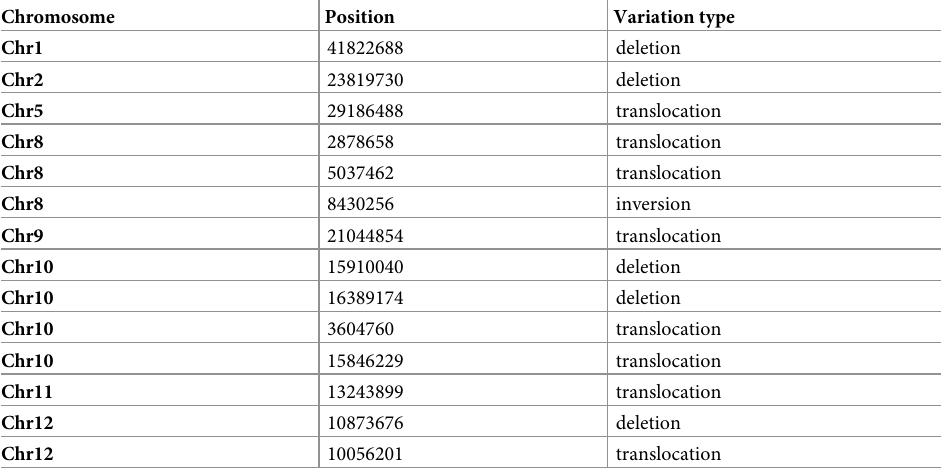
premature stop codon. Consequently, the mutant line flowered 35 days earlier than Gimbozou under natural LD light conditions, similarly to G123 . When comparing the expression patterns of the main flowering regulatory genes in X61 and G123 under the LD conditions, as expected Hd3a displayed higher levels in both mutant lines compared to their corresponding wild types. The RFT1 levels were higher in Gleva than in G123 , probably due to their differences in vegeta- tive cycle duration. Despite there being some connections between the two flowering regula- tory pathways, Hd3a expression is regulated by Hd1 and Ehd1 , while RFT1 expression is regulated by Ehd1 [32]. In regions located at northern latitudes with a temperate climate, varie- ties can often be found with non-functional Hd1 alleles. As Hd1 is an inhibitor of flowering under LD conditions, in these situations, flowering is governed by Ehd1 . This is not the case of Gleva because it contains an Hd1 functional allele, which implies that both regulatory path- ways are functional in Gleva [6]. This agrees with the fact that the Hd3a expression levels in the G123 mutant are higher than in the wild type, which indicates that Hd3a also promotes flowering in G123 . Table 5. Structural variations specific of G123 and Epool that were absent in